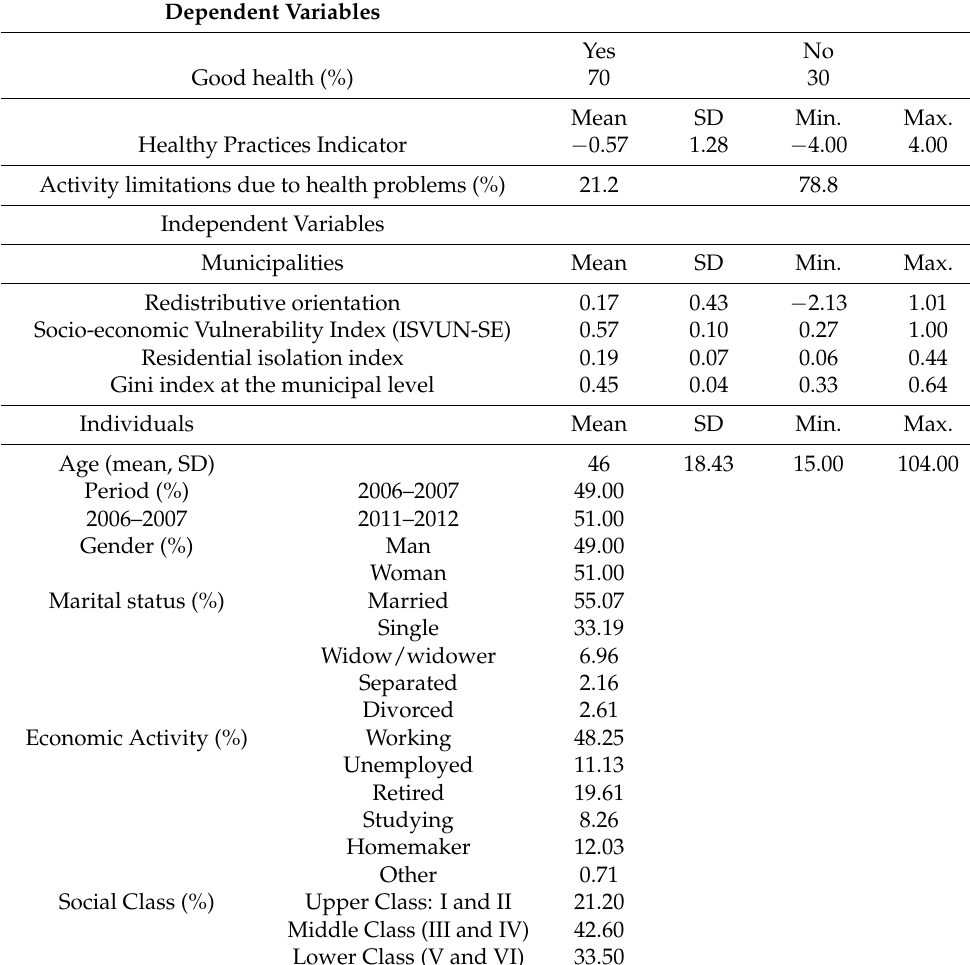
Table 1. Descriptors of the variables included in the